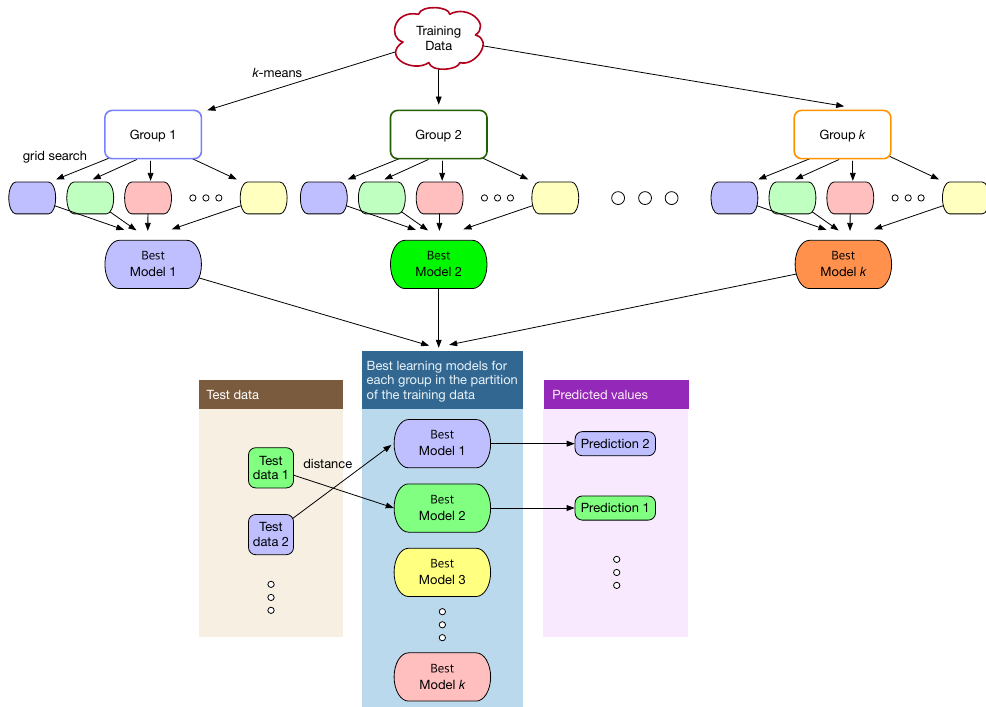
Figure 4. Determining the optimal hyperparameters of a machine-learning method for each cluster obtained by using unsupervised k -means